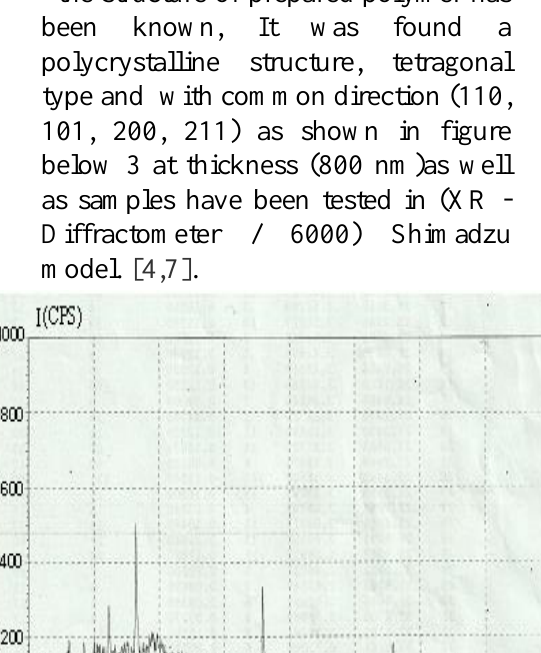
Fig.1: chemical formula of polyaniline.